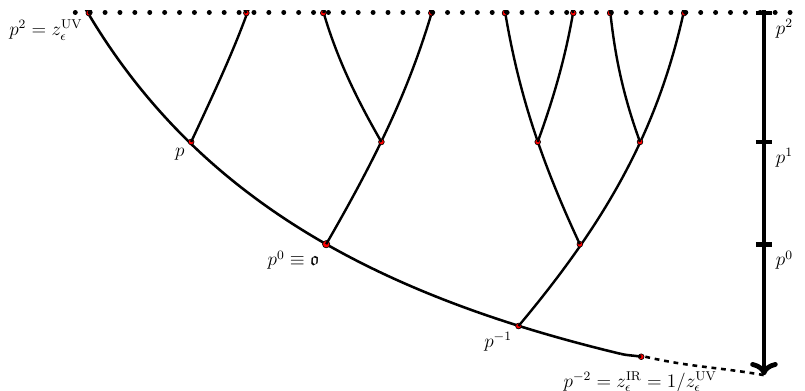
Figure 5. Diagram illustrating the UV and IR cuto(cid:11) introduced in (3.24). For illustrative purpose, we have picked a UV cuto(cid:11) at p 2 , and the IR cuto(cid:11) at p (cid:0) 2